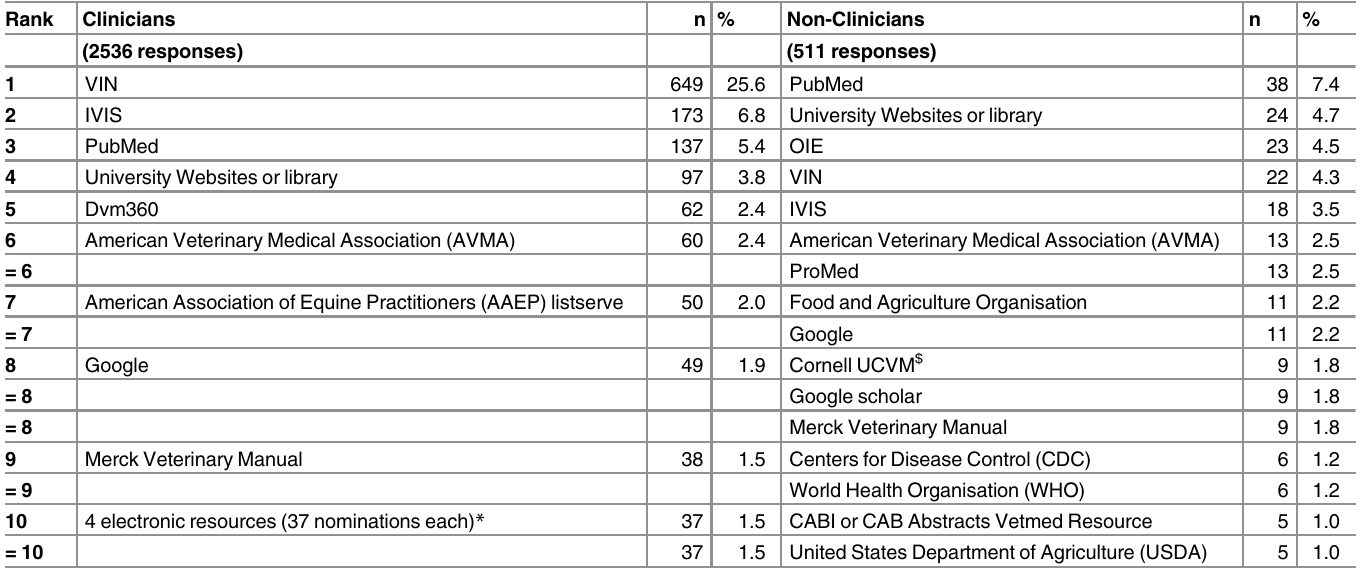
Table 7. Top ten electronic resources most accessed as nominated by clinicians and non-clinicians. Respondents could nominate up to 10 electronic resources.